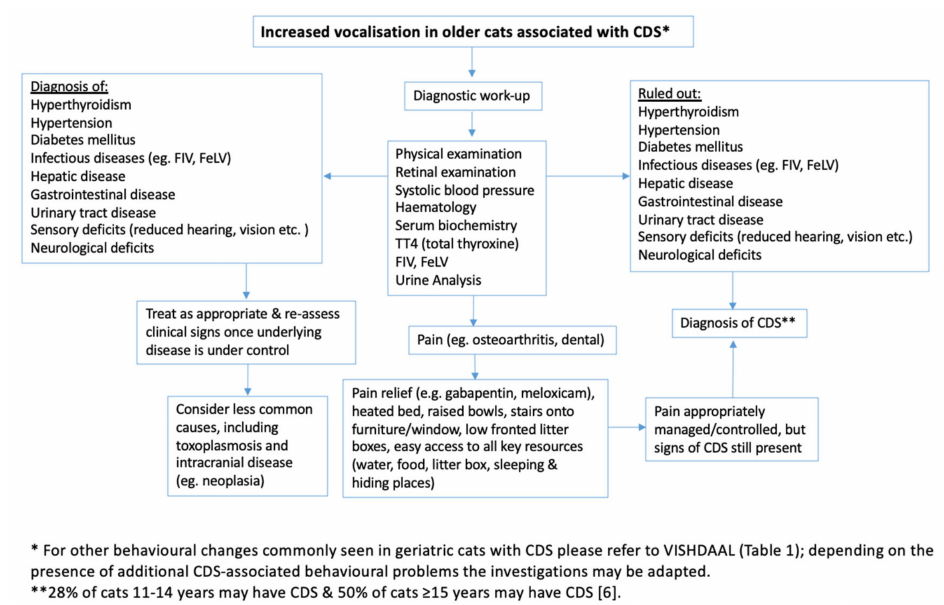
Figure 1. Algorithm for diagnosis of Cognitive dysfunction syndrome (CDS). FIV —feline immunodeficiency virus, FeLV —feline leukemia